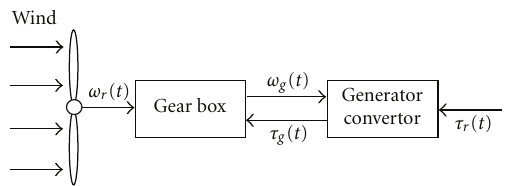
Figure 1: Logic diagram of the wind turbine, where only two of the three blades are